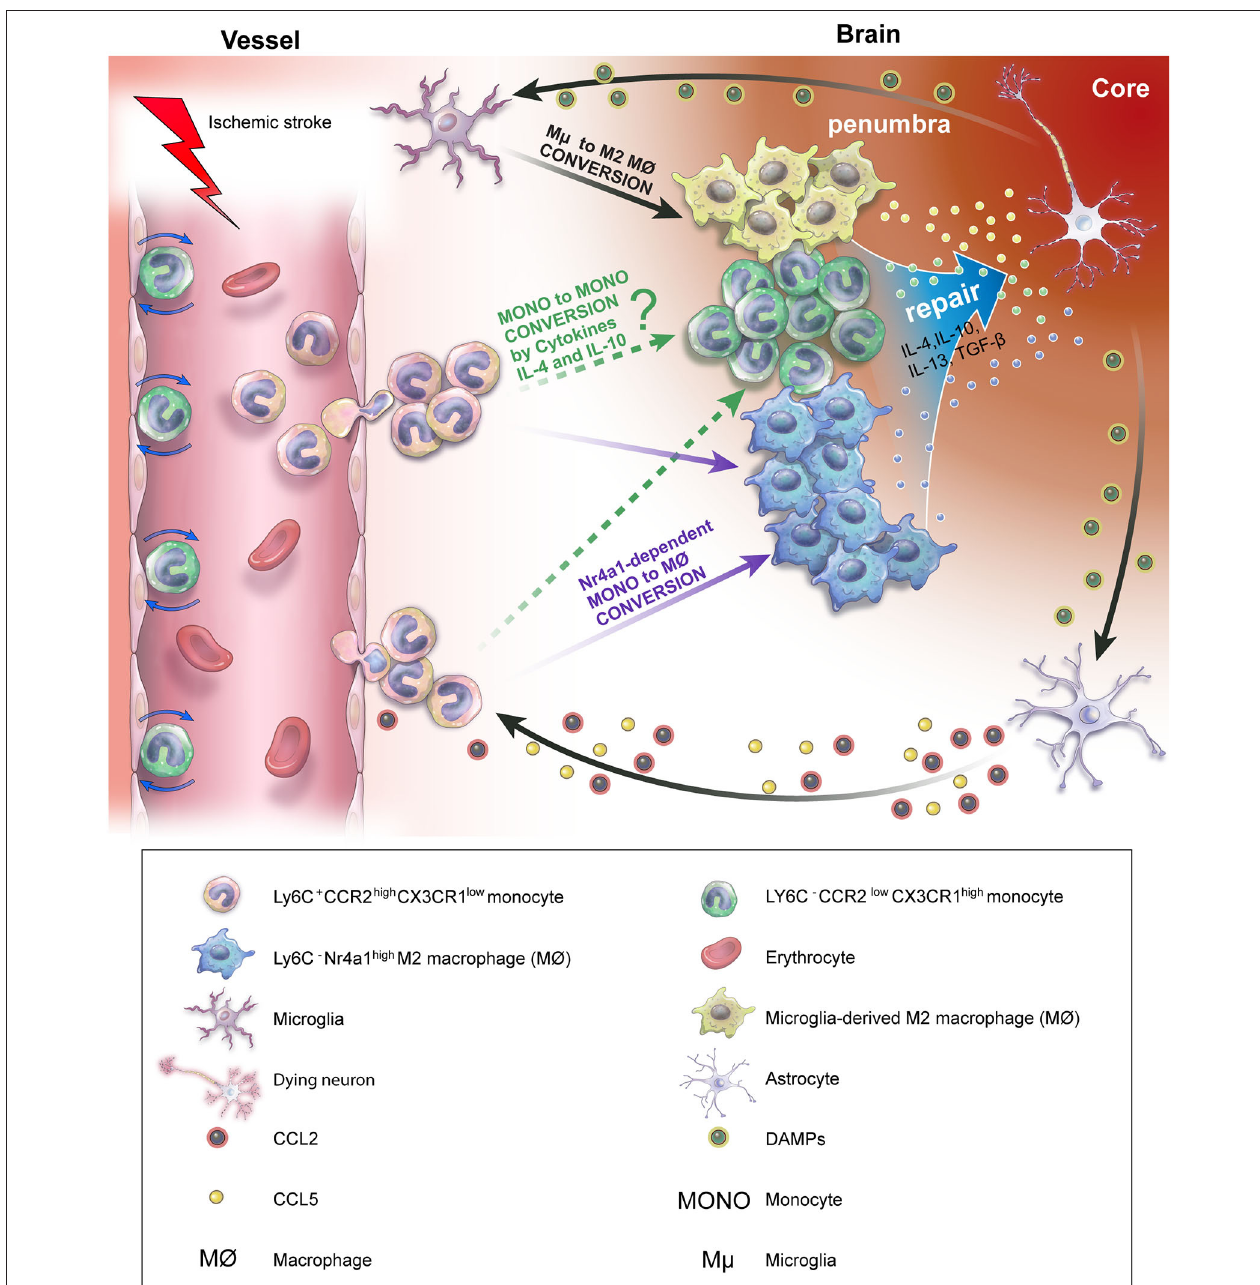
FIGURE 2 | Ly6C + pro-inflammatory monocyte conversion and contribution to ischemic stroke recovery in vivo . After the onset of ischemic stroke, DAMP released by dying neurons activates microglia and astrocytes. C-C motif ligand 2 (CCL2) and C-C motif ligand 5 (CCL5), which are secreted by activated microglia and astrocytes, induce the infiltration of Ly6C + pro-inflammatory monocytes into the injury site. Infiltrating Ly6C + monocytes convert into M2 macrophages depending on the presence of Nr4a1 (MONO to MØ). In addition, activated microglia are polarized into M2 macrophages, releasing anti-inflammatory cytokines, resulting in ischemic stroke recovery. However, whether the conversion of Ly6C + pro-inflammatory monocytes to Ly6C − anti-inflammatory monocytes (MONO to MONO) occurs in the brain, attenuating neuroinflammation following ischemic stroke, remains